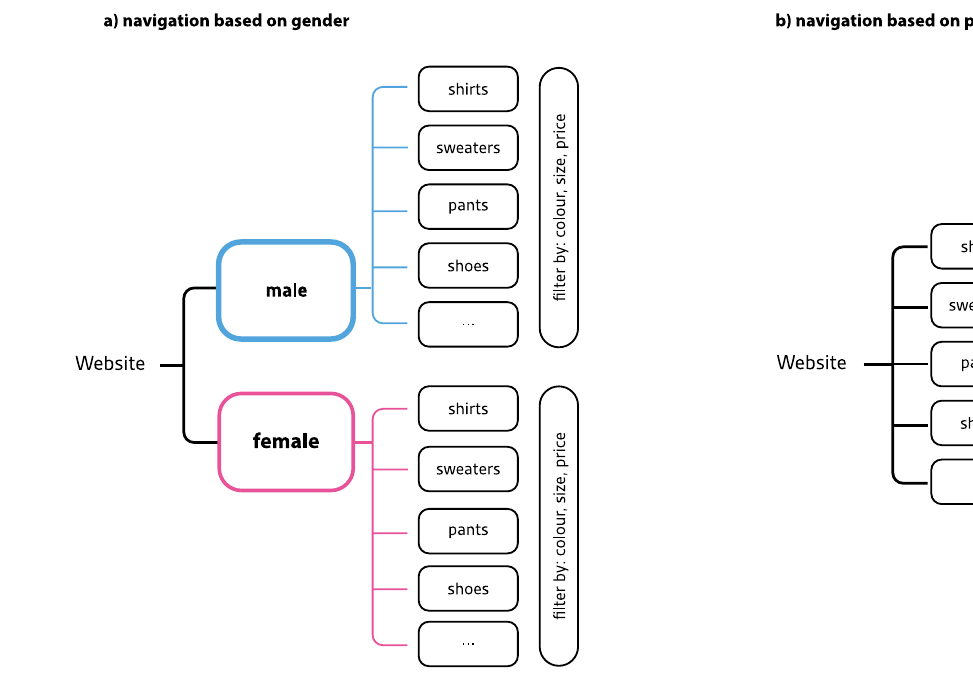
Diagram 1 (top): The British fashion company John Lewis was the first British company to abolish gender denominations in children's clothing; there is only one category: "Girls & Boys". The multifaceted prints and designs have not changed and the shop layout only has one designated area for children’s clothing. (“A T-shirt should be just a T-shirt – not a T-shirt just for girls or just for boys.”). 3 Graphic: Claudia Herling and Katja Becker.